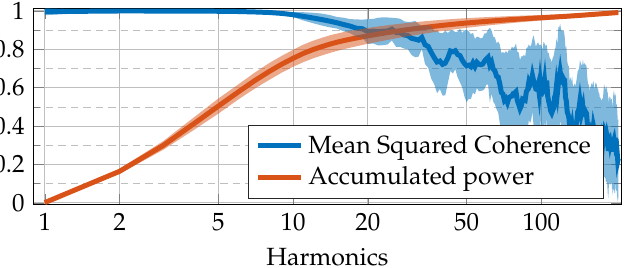
Figure 10. MSC results. Blue: MSC value as a function of the considered harmonic (frequency). Orange: accumulated power (normalized from [ 0,1 ] ) concerning the number of harmonics. The mean and the confidence interval of the testing set are presented along with the cross-validation scheme for all the studied engine velocities and loads (time delay is fixed as 100 ms). The horizontal axis is on a logarithmic scale.